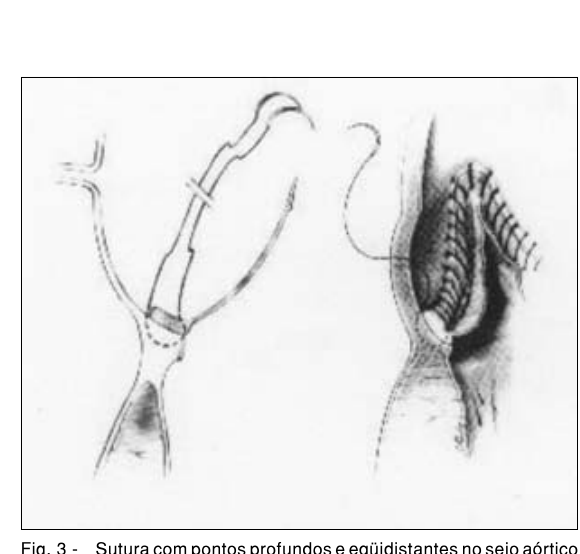
Fig. 2 - TrŒs pontos eq(cid:252)idistantes de polipropileno 3-0 na posi(cid:231)ªo supra-anular pr(cid:243)ximo ao ponto mØdio de cada seio a(cid:243)rtico (reproduzida com permissªo do Dr. Mark F. O(cid:146)Brien).